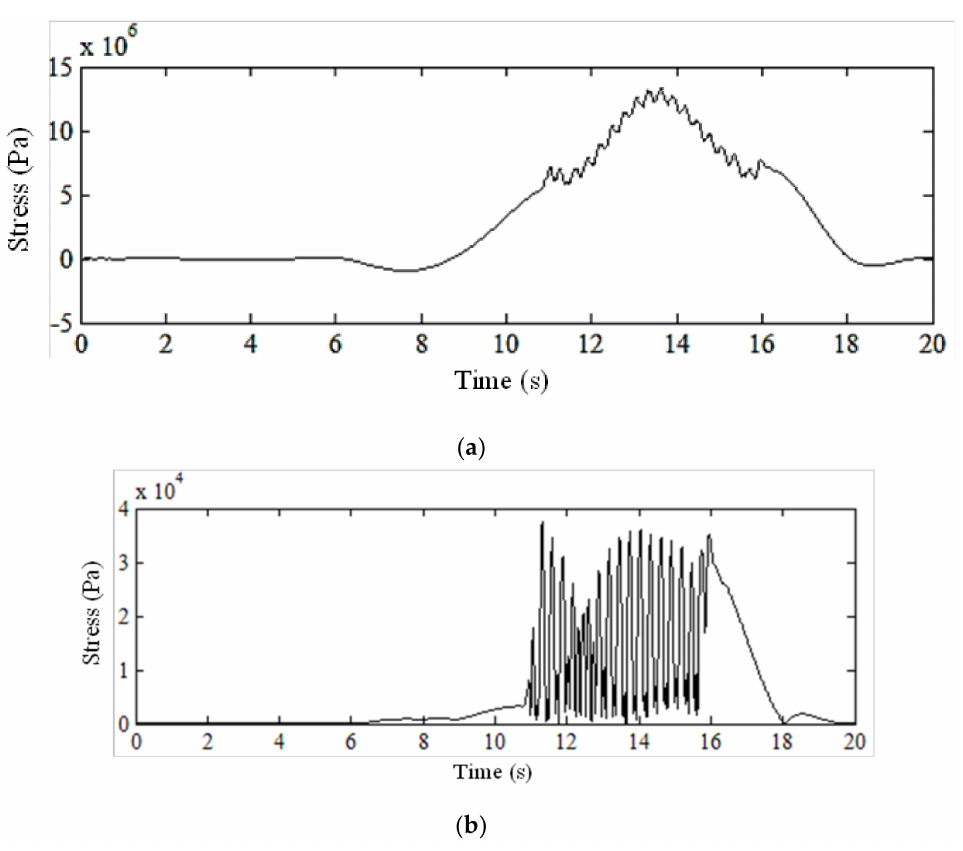
Figure 7. Curves of nominal and shearing stress on the critical plane; ( a ) normal stress; ( b ) shear- ing